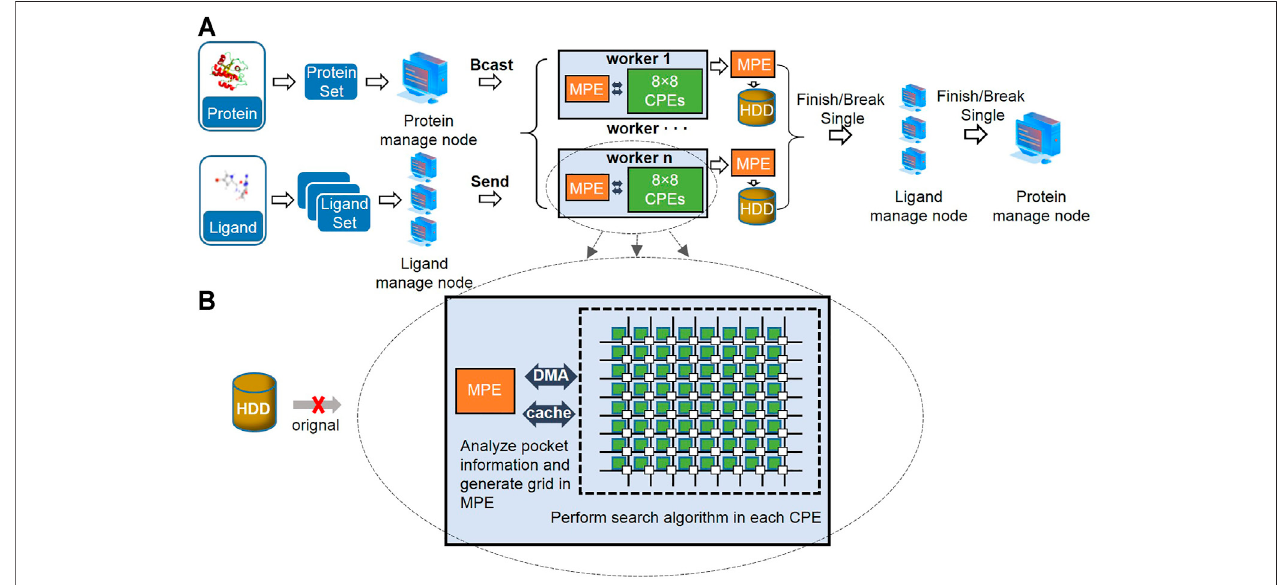
FIGURE1| ParallelframeworkofVina@QNLMbasedonSunwaysupercomputer,large-scaleparallelismformoleculardockingtasks (A) ,anddatacommunication and optimization between MPE and CPE (B) .